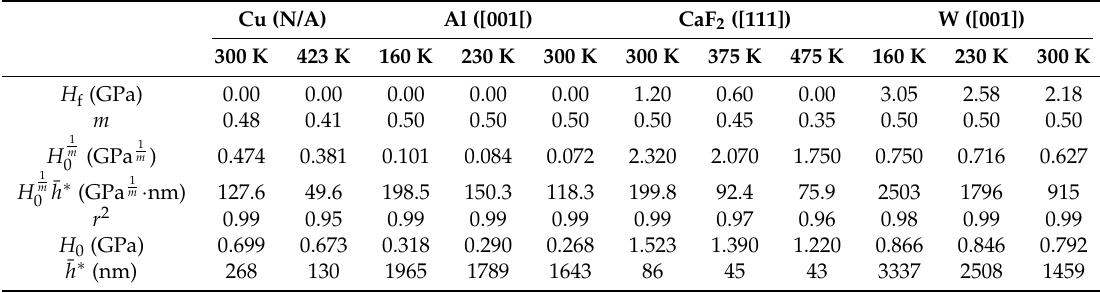
Table 1. Parameter calibration of the proposed theoretical model for single crystal Cu [24], Al [16], CaF 2 [25] and W